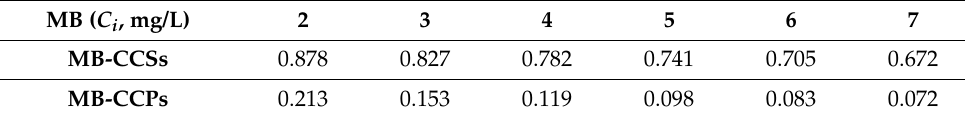
Table 4. Dimensionless separation factor R L